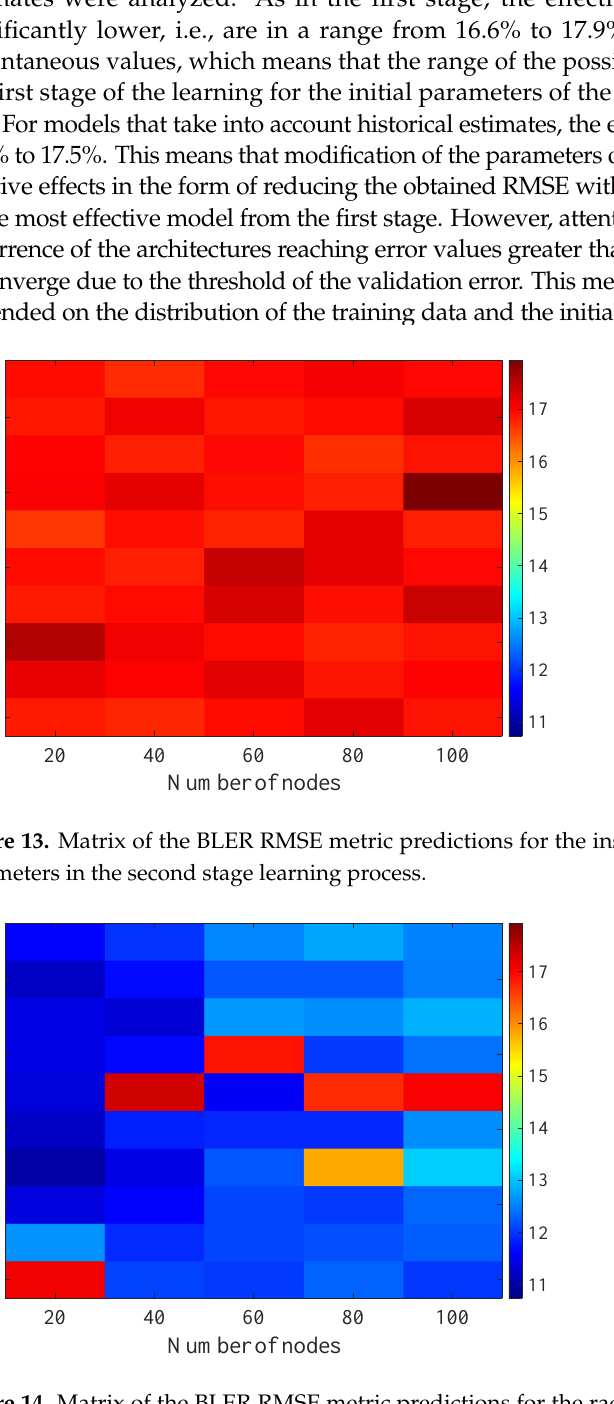
Figure 14. Matrix of the BLER RMSE metric predictions for the radio parameters history window W = 5 in the second stage learning